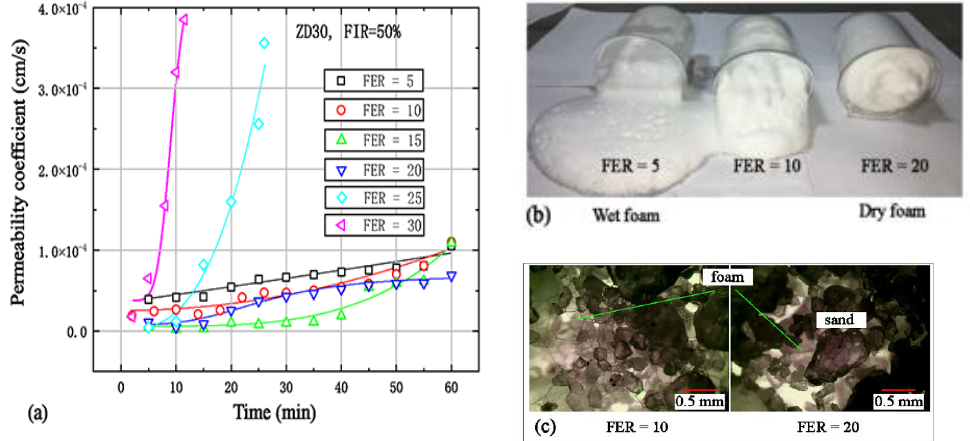
Figure 6. E ff ect of FER on conditioned sand permeability. ( a ) Conditioned sand permeability coe ffi cient under di ff erent FERs, ( b ) flowability of foam under di ff erent FERs, and ( c ) foam defoaming between sand particles when FER = 20.